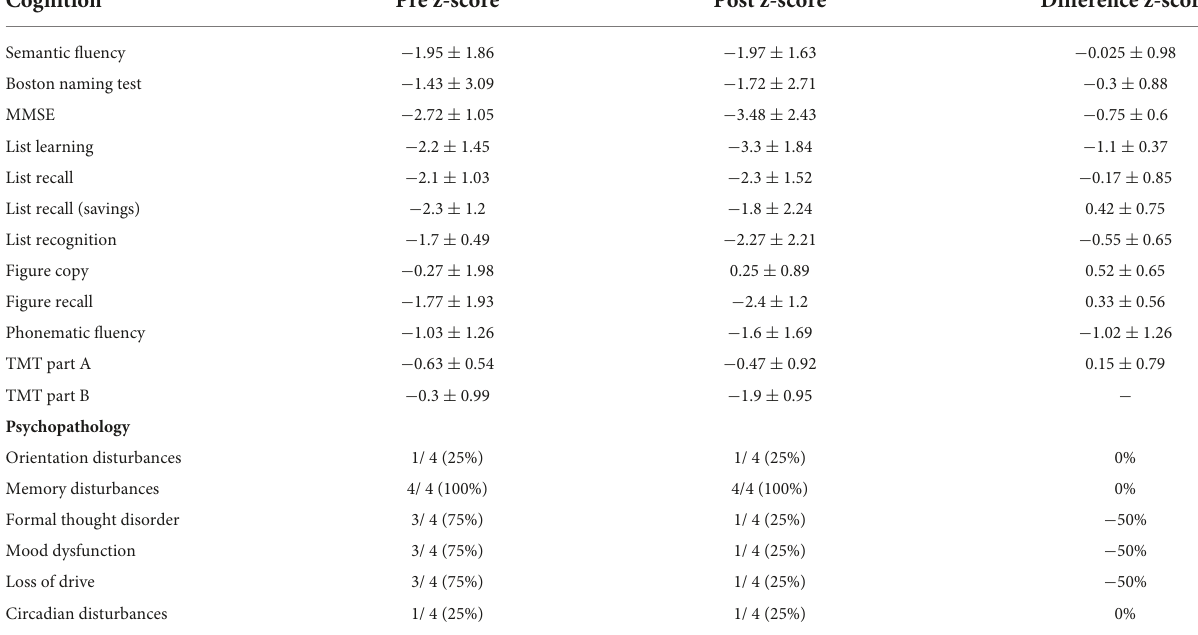
TABLE 2B Neuropsychological and psychometric data in patients with